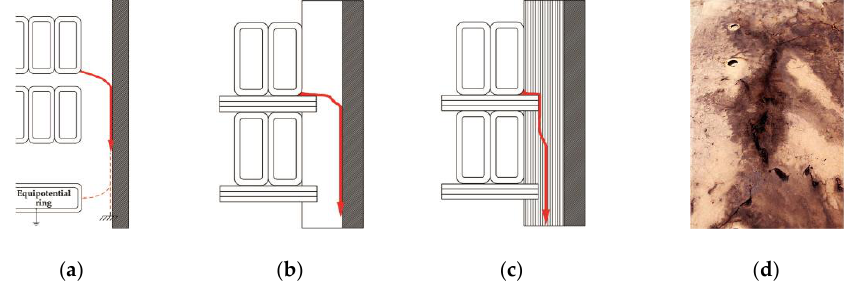
Figure 1. Possible scenarios of surface discharge formation in transformer insulation system: ( a ) flashover along the barrier to the earthed construction part or equipotential ring (the flashover bypasses the intercoil spacers); ( b ) flashover across the surface of intercoil spacer; the discharge may later develop along the lateral surface of the strip (or on the surface of barrier — as shown in Figure 1a; ( c ) breakdown of distance strip; and ( d ) photo of a fragment (~450 800 mm) of the pressboard barrier strongly degraded by surface discharges (numerous carbonized traces are visible).